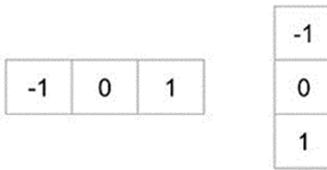
Figure 1. Masks used to obtain the gradient images on the x- and y-axis. As g x and g y refer to the images filtered in x - and y -axis, the gradient size ( g ) and its direction ( θ ) can be calculated as in Equation (1):